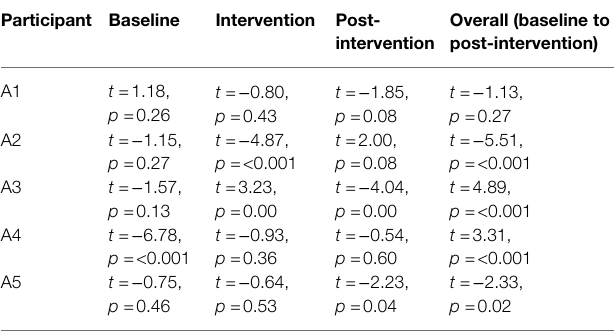
TABLE 1 | Times-series analysis results for participants A1–A5 using SuperBetter .